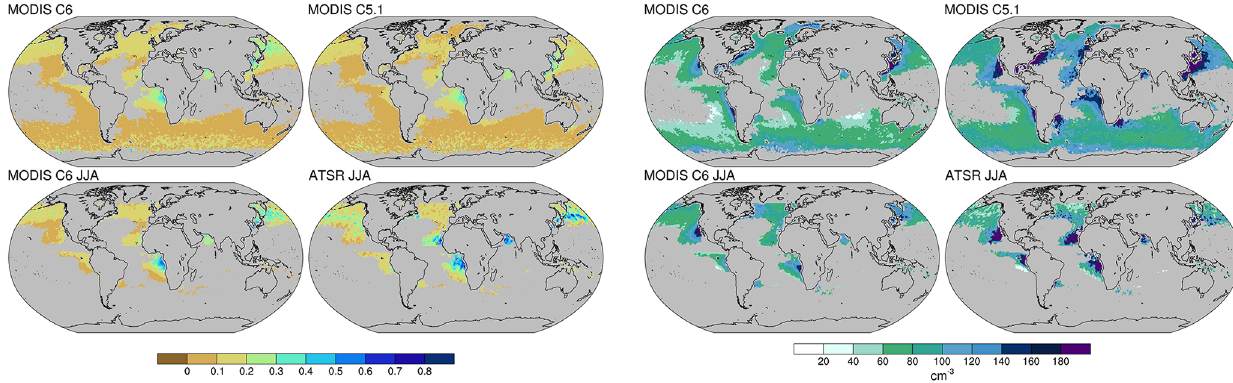
Figure A1. Annual maps (top) and a JJA seasonal maps (bottom) for AODf (left frame) and CDNC (right frame) for different retrievals with MODIS and ATSR sensor